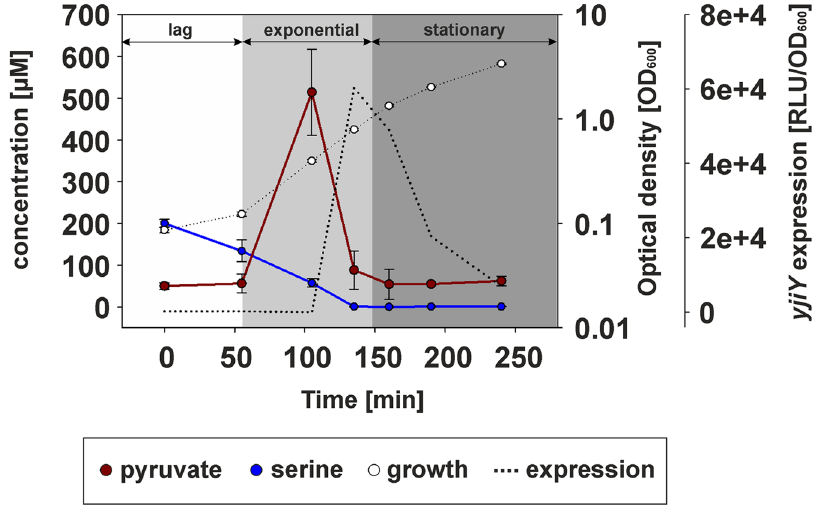
Figure 3. Determination of changes in extracellular concentrations of serine and pyruvate during growth of E . coli . E . coli MG1655/pBBR yjiY - lux was cultivated in LB medium, and growth (OD 600 ) and luminescence were monitored. At the times indicated, cells were harvested, and serine and pyruvate levels were quantified by hydrophilic interaction liquid chromatography. All experiments were performed in triplicate, and the error bars indicate the standard deviation of the means. The growth phases of E . coli are marked as following: lag phase (white), exponential growth (light grey) and stationary phase (dark grey).